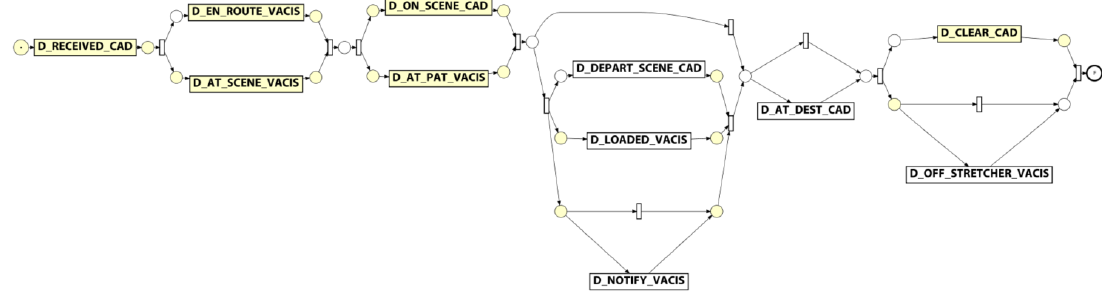
Figure 10. QAS conformance model derived from sample